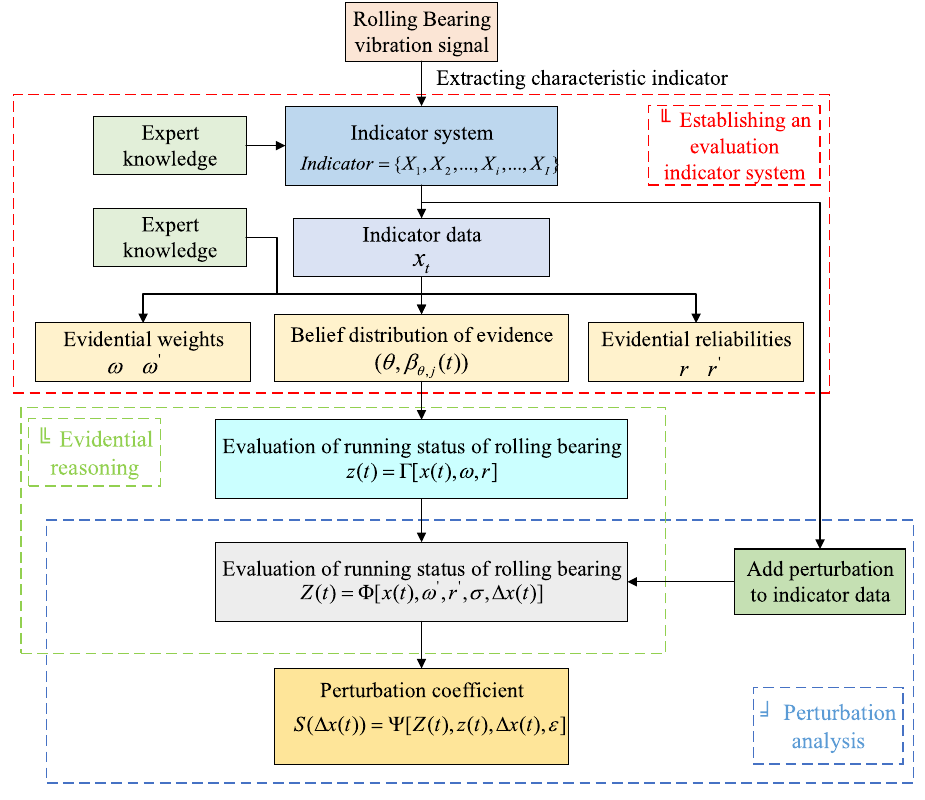
Figure 1. Evaluation of bearing performance considering